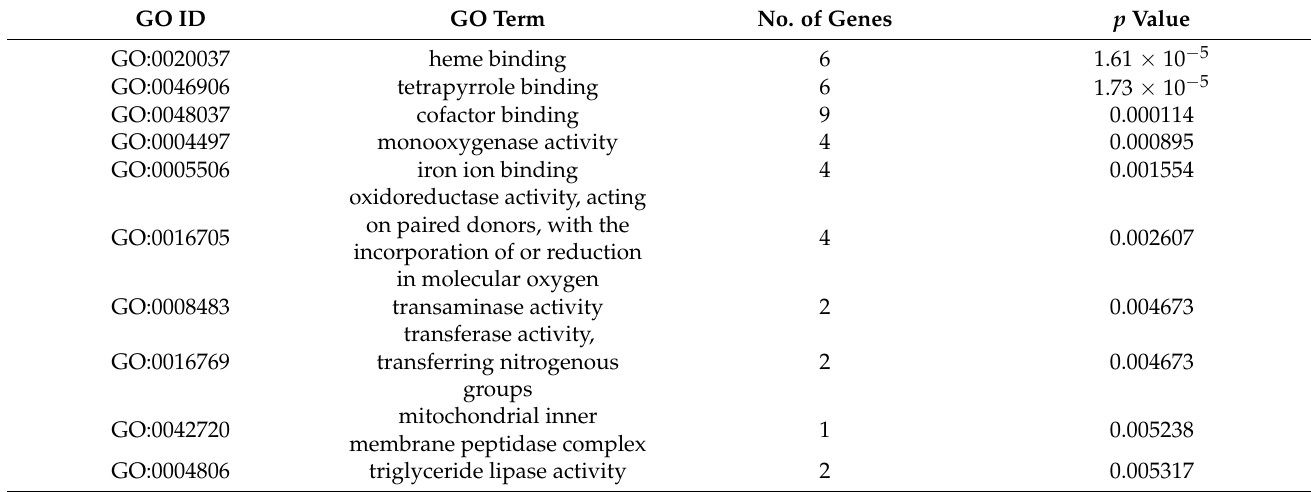
Table 1. Enrichment analysis of top ten GO terms related to upregulated and downregulated genes in the brains of cadmium-exposed bees.